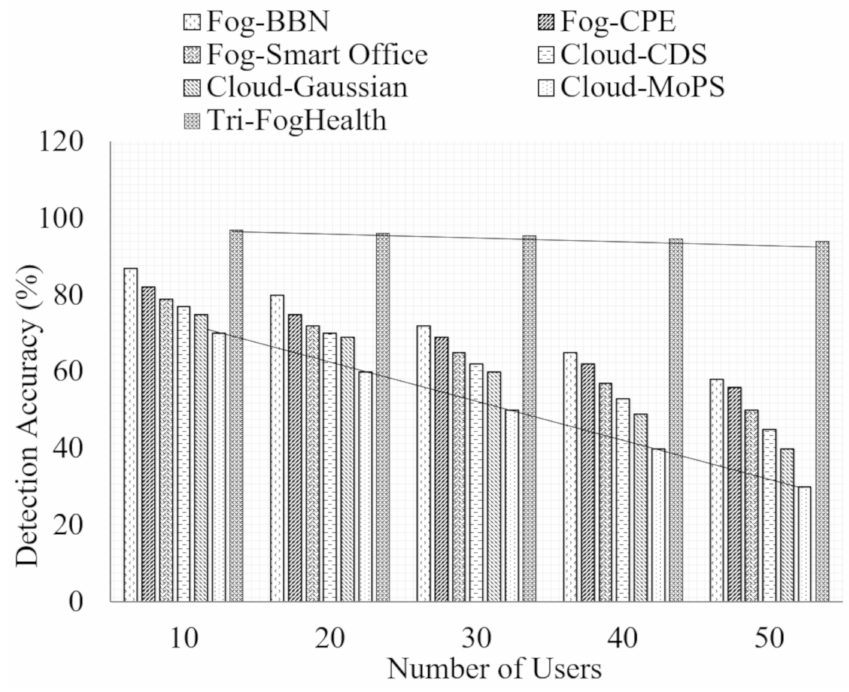
Figure 12. Comparison of Detection